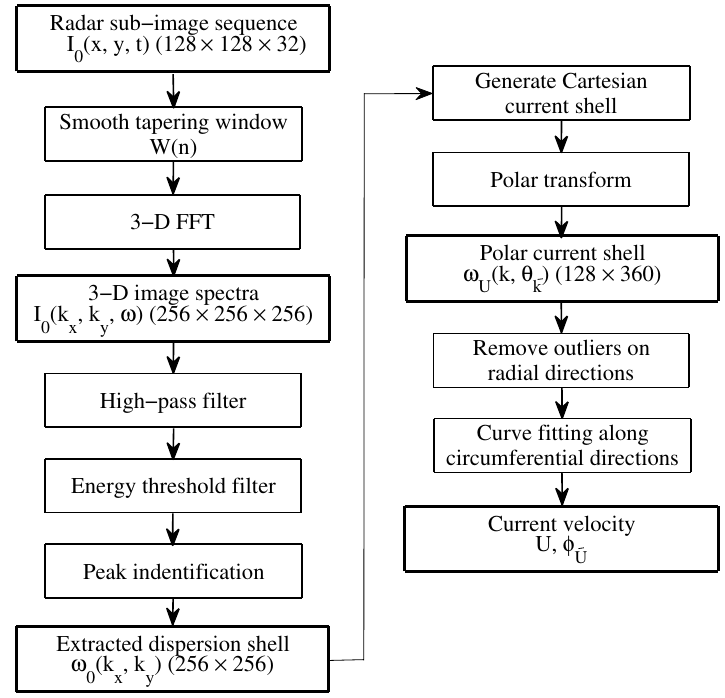
Figure 1. A block diagram of the current inversion procedure. The various quantities are defined in the